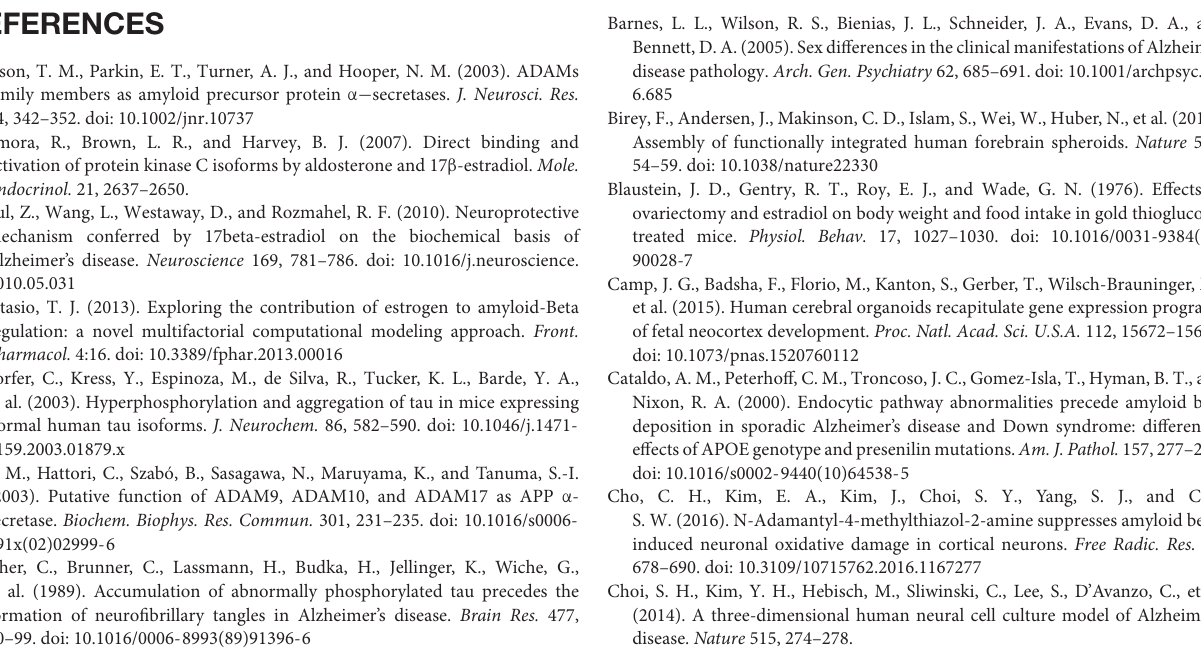
Supplementary Figure 1 | Cerebral organoids harvested on day 60 showed greater expression of brain-relevant genes compared to those harvested on day 30. (A) Average gene expression normalized to that of GAPDH : pluripotency marker OCT4 , hippocampal marker PROX1 , forebrain marker FOXG1 , neuronal markers MAP2 , NeuN , and TUJ1 , deep-layer neuron marker TBR1 , neural progenitor cell marker Nestin , and glutamate transporter marker vGLUT1 ; gene expression was measured in cerebral organoids harvested on day 30 (M1) and day 60 (M2) (n = 3 for each group). Supplementary Figure 2 | Recording of Barnes maze test performed by